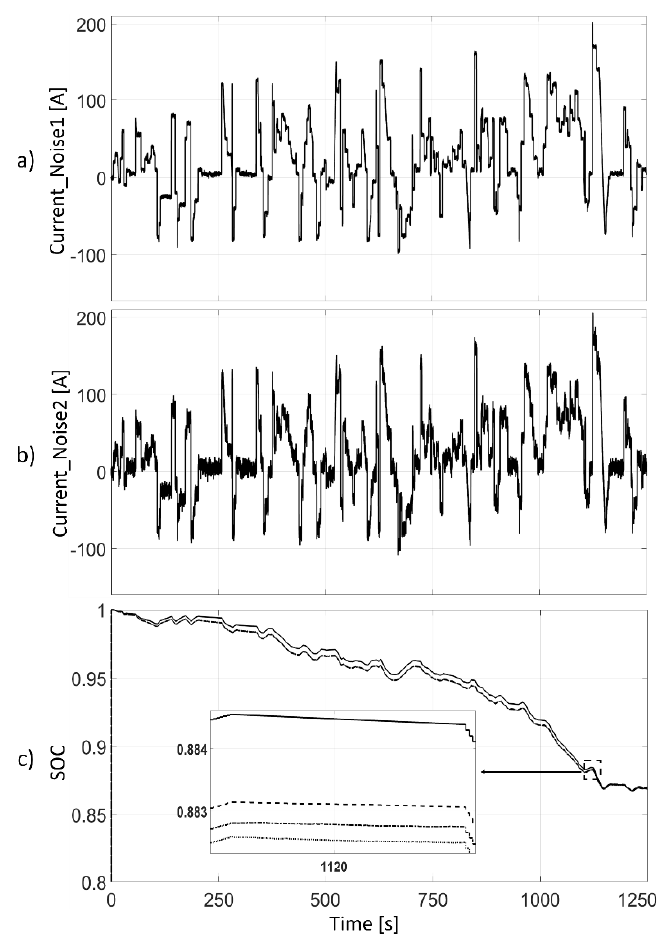
Figure 11. Robustness to noise on the current measurement. ( a ) Current with type 1 noise. ( b ) Current with type 2 noise. ( c ) SOC: expected without noise (solid line), estimated without noise (dashed line), estimated when the current is disturbed by the type 1 noise (dash-dotted line) and estimated when the current is disturbed with the type 2 noise (dotted line).